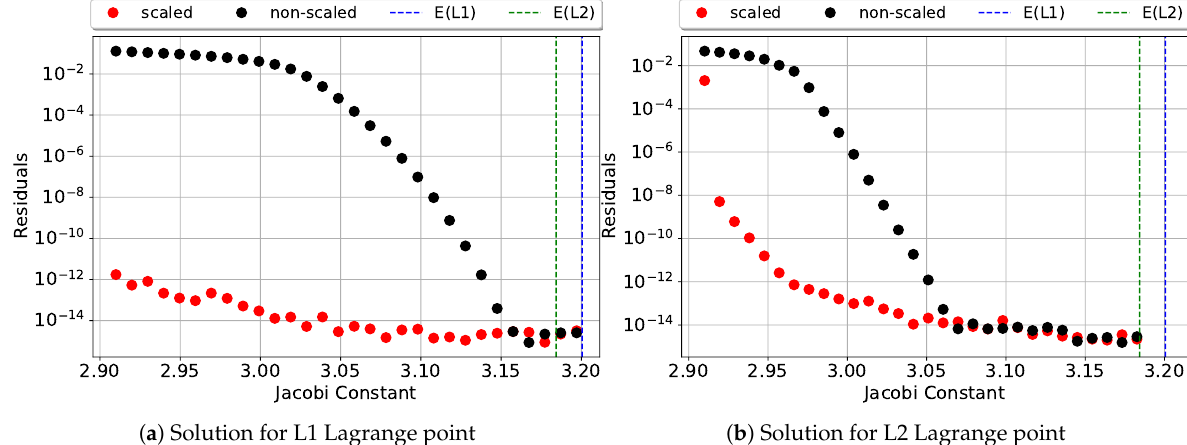
Figure 3. Accuracy comparison of the scaled vs. non-scaled solution of Lyapunov orbits. The scaled solution utilizes the time transformation given by Equation (23) and clearly produces more accurate results as the Jacobi constant decreases. The scaled formulation was used in all of the following results for Lyapunov orbits.